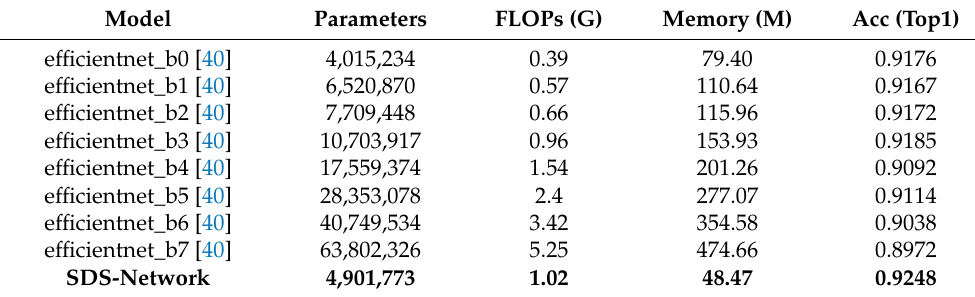
Table 6. Comparison of SDS-Network model and efficient series of algorithms.